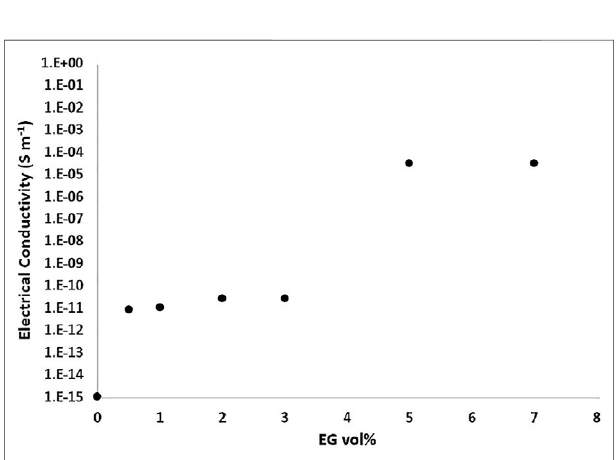
FIGURE 8 | DC volume electrical conductivity of the PEEK/EG composites at room temperature.